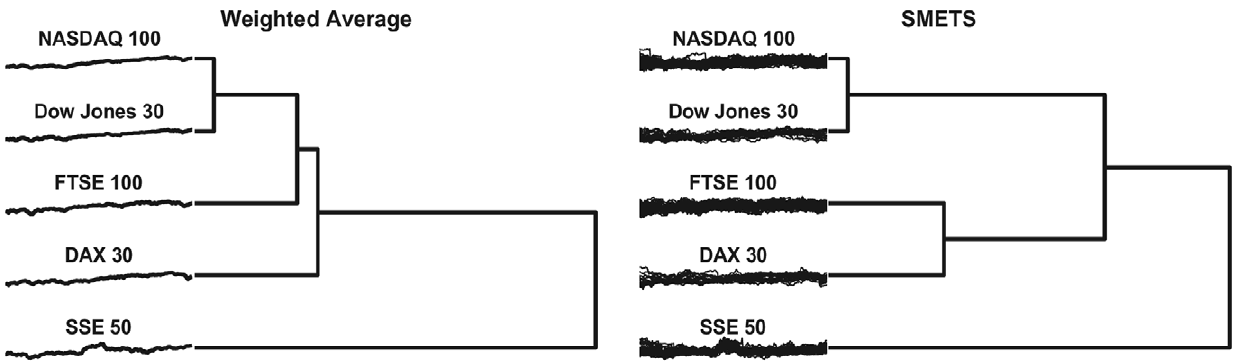
Figure 3. Hierarchical clustering of five stock indices. Indices were clustered based on the traditional weighted average method and on SMETS . The dendrogram reveals the relative distances between each entity. The time series considered by each method are represented to the left.